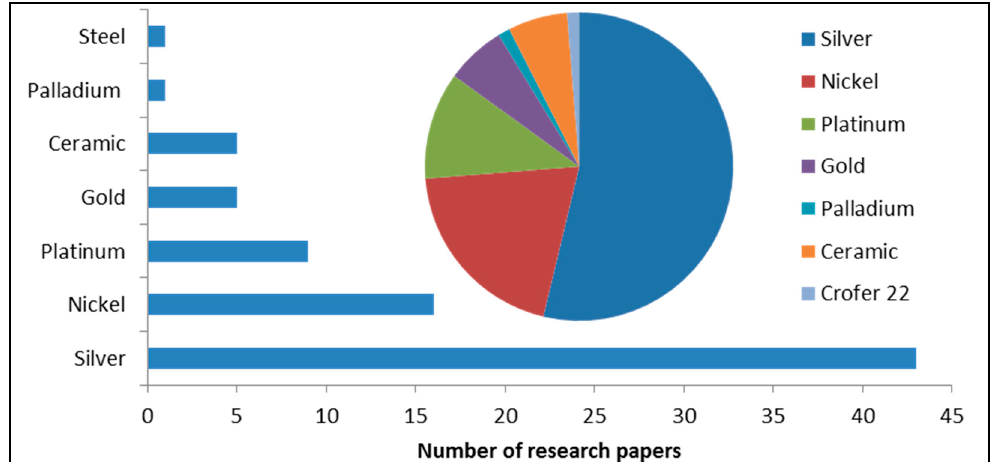
Figure 9. Current collector materials used in µT-SOFC tests reported in literature between 2015 and 2020.